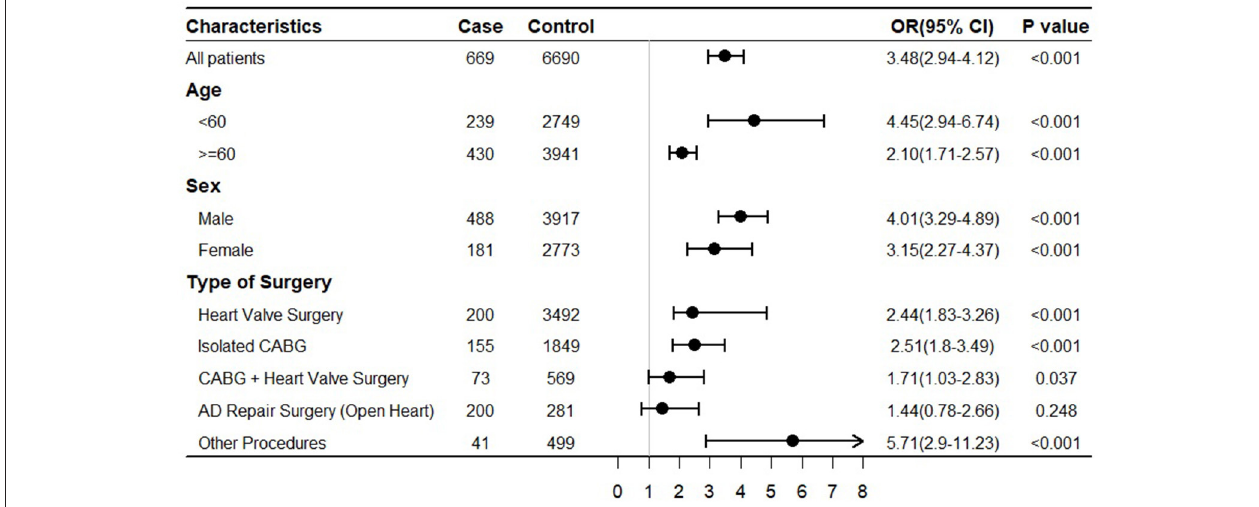
Frontiers in Cardiovascular Medicine |